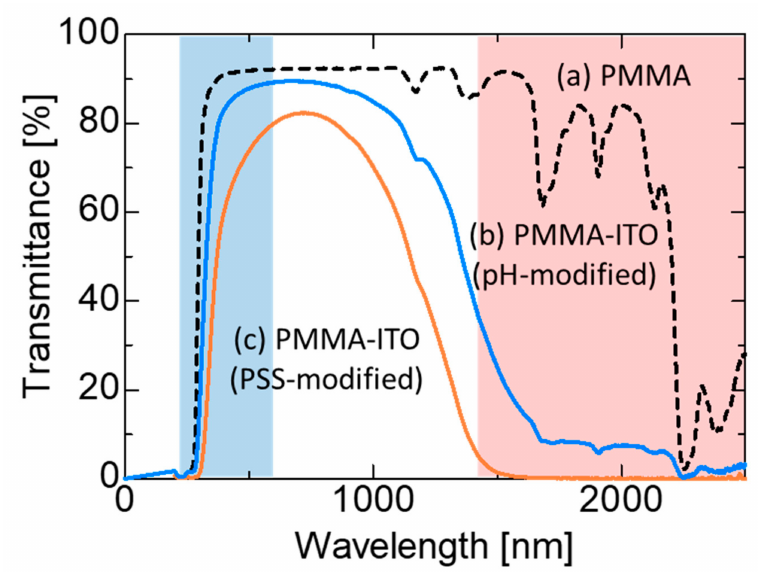
Figure 5. Transmittance properties of ( a ) PMMA and the PMMA-ITO composite pellets obtained using ITO nanoparticles modified using ( b ) pH adjustment and ( c )